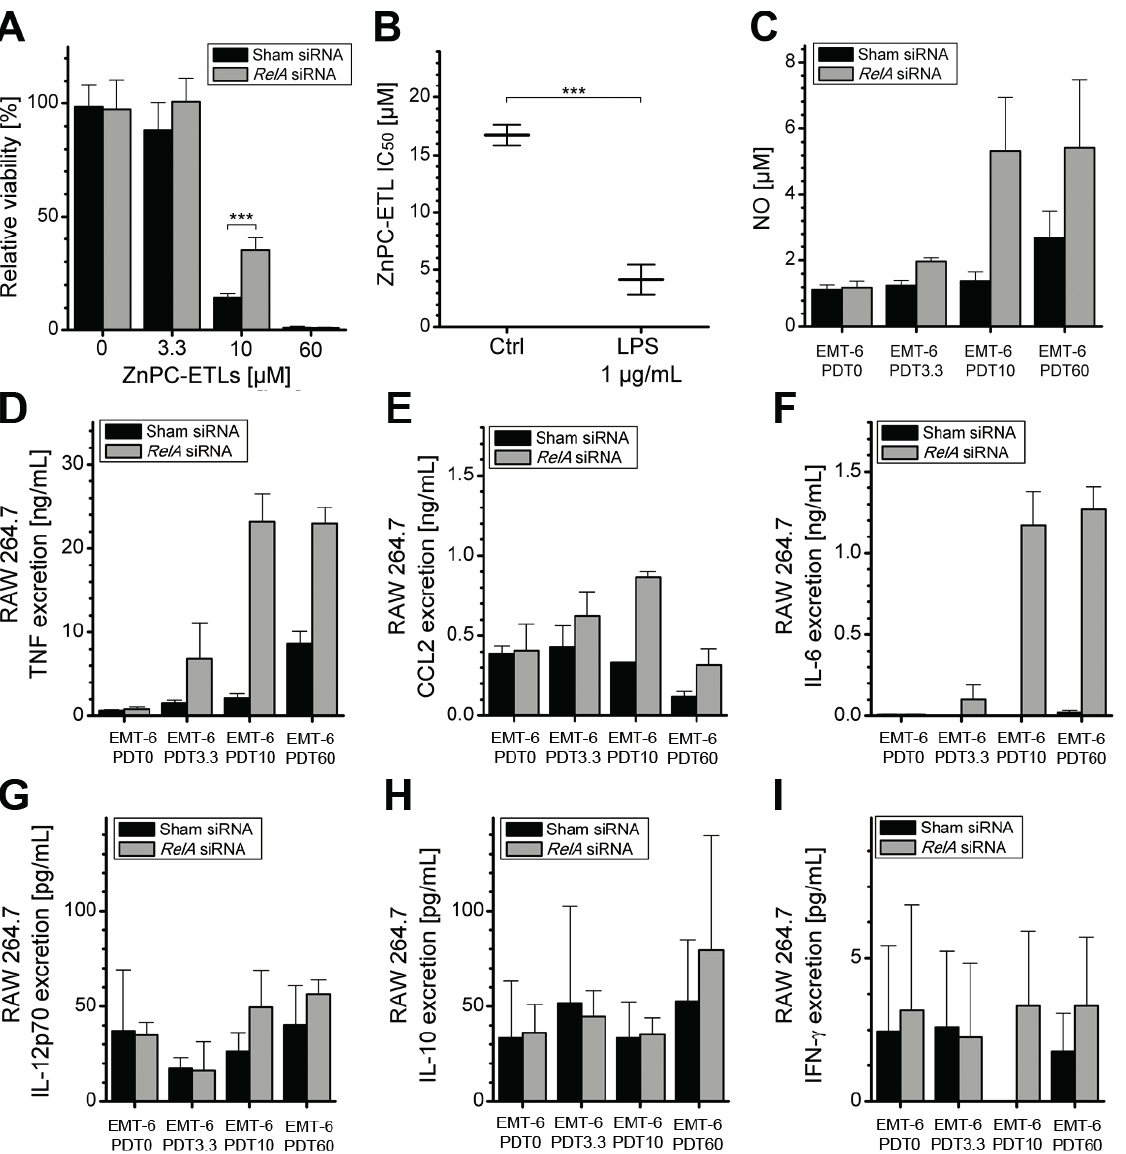
Figure 2. ( A ) EMT-6 cells were treated with either sham siRNA (black bars) or RelA siRNA (grey bars) and subsequently subjected to PDT with increasing concentrations of ZnPC-ETLs (indicated by the number after “PDT”). Cell viability was assessed 24 h after PDT and subsequent hypoxic incubation (mean ± SD, N = 6, student’s t -test). *** p < 0.005; ( B ) ZnPC-ETL IC 50 values as determined on EMT-6 cells that were preconditioned with LPS versus non-preconditioned cells. *** p < 0.005; ( C ) NO production by RAW 264.7 macrophages 24 h after stimulation with supernatant from PDT-treated EMT-6 or EMT-6- RelA kd cells (mean ± SD, N = 3); ( D – I ) After 24 h of incubation with supernatant from PDT-treated EMT-6 or EMT-6- RelA kd cells, the medium from the RAW 264.7 cells was assayed for cytokine levels (means ± SD, N = 3). The ZnPC-ETL concentrations ( x -axes) refer to final lipid concentration (indicated by the number after “PDT”). The ZnPC:lipid molar ratio was 0.003